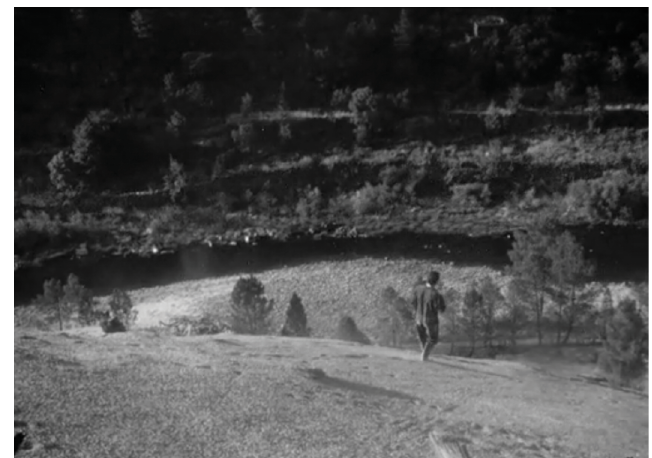
Figure 1 – Still from Corrente (2008) by Rodrigo Areias.